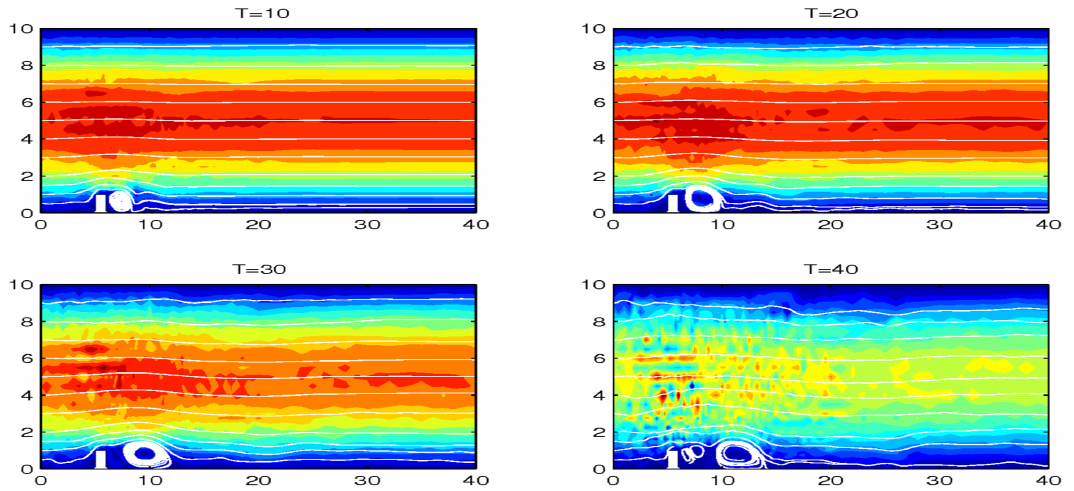
Figure 3. Four snapshots ( t = 10,20,30, and 40) of an under-resolved direct numerical simulation of the NSE, plagued with spurious oscillations. Shown are streamlines overlaid above speed contours | v ( x , t ) | . This figure was originally published in [11]. h